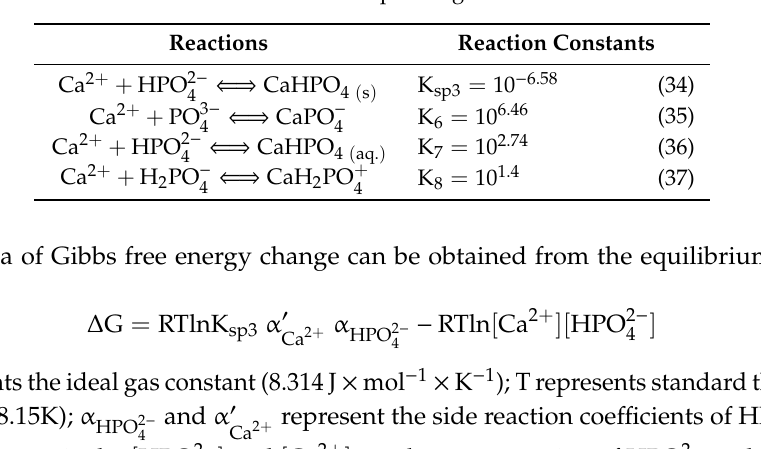
Table 6. Reactions and corresponding reaction